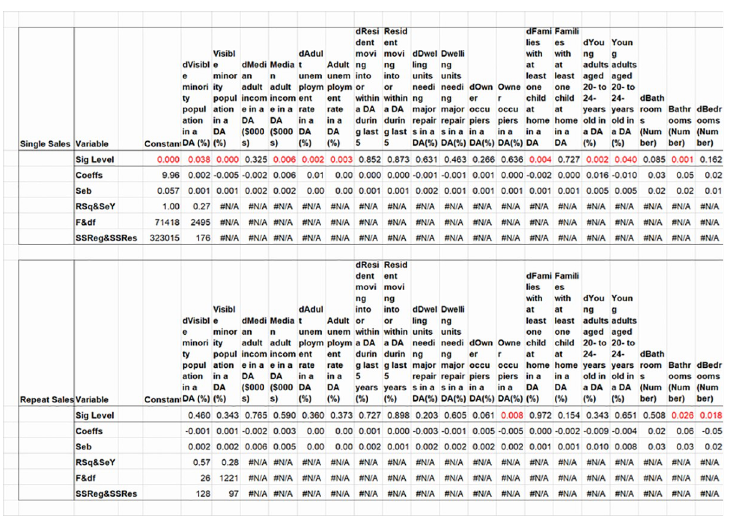
Fig 2. Two models’ selected linear regression